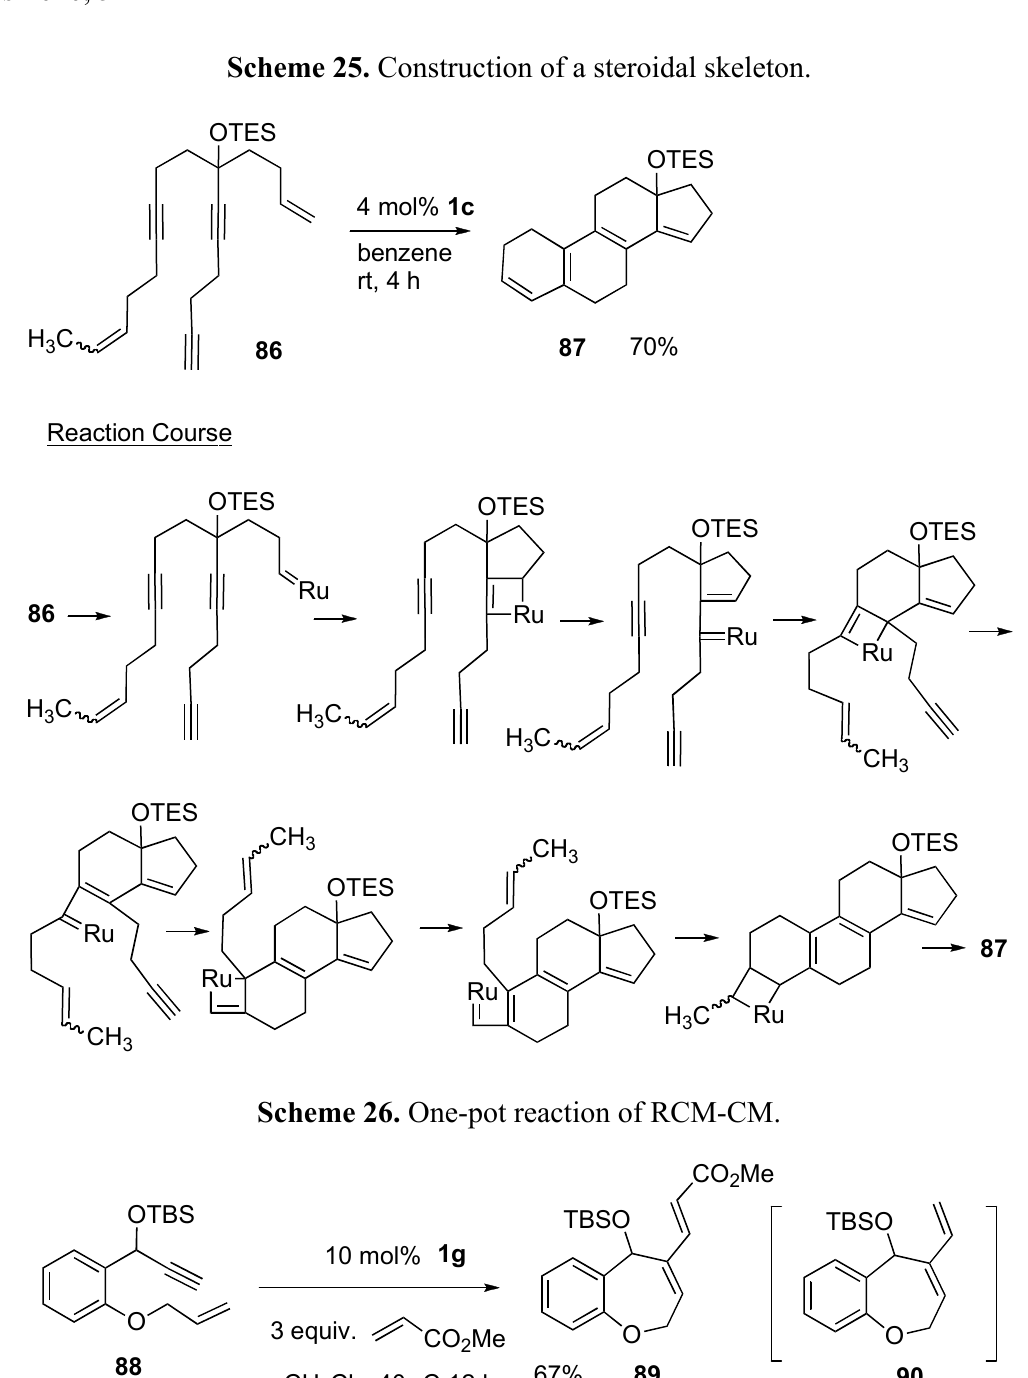
Scheme 25. Construction of a steroidal skeleton.